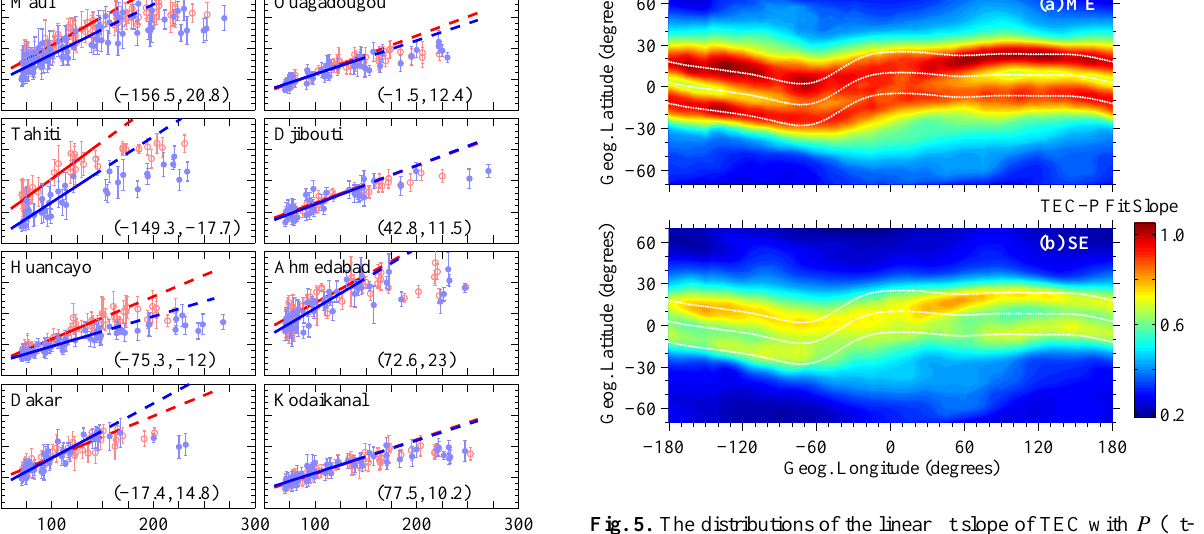
Fig. 5. The distributions of the linear fit slope of TEC with P (fit- ting for P < 140, see Fig. 2) at 14:00LT. Three lines in each panel correspond to dip equator + 15 ◦ , dip equator, and dip equator − 15 ◦ ,